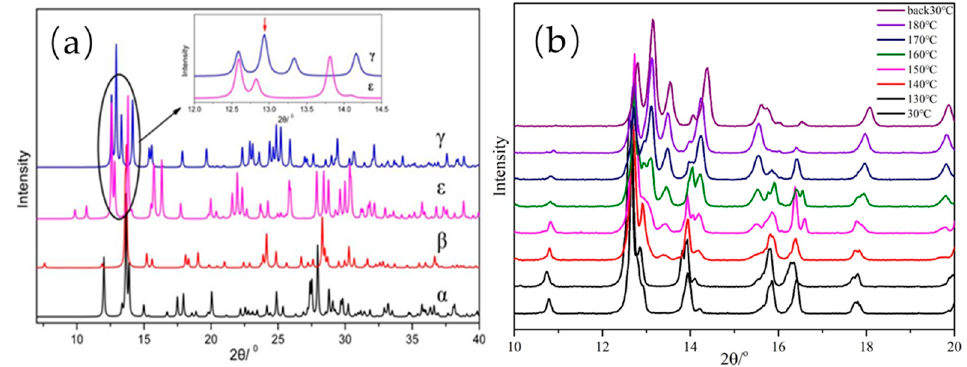
Figure 9. X ‐ ray diffraction (XRD) patterns of (a) the conformers from four polymorphs of CL ‐ 20 and Figure 9. X-ray di ff raction (XRD) patterns of ( a ) the conformers from four polymorphs of CL-20 and ( b ) (b) ε‐ CL ‐ 20 at various temperatures. ε -CL-20 at various